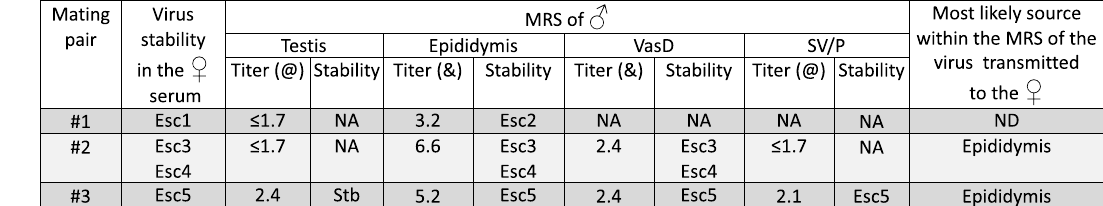
suggesting that all these organs can be a source of 2 × 202(T)stb virus that was detected in the female serum (Fig. 3d). In contrast, the 2 × 141(T) virus was attenuated in these components of MRS (Fig. 1d – g). Only a single female (5%; n = 20) developed a detectable anti-ZIKV NA titer after mating with male infected with 2 × 141(T) virus (Fig. 3b, d). However, infectious 2 × 141(T) virus was not detected in the serum nor the brain of this animal, precluding subsequent analysis of the origin of the transmitted 2 × 141(T) virus in the MRS. We also analyzed ST ef fi ciency of the 2 × 202/141(T) virus (Fig. S2) 22 , which contains two target sequences for both mir-202